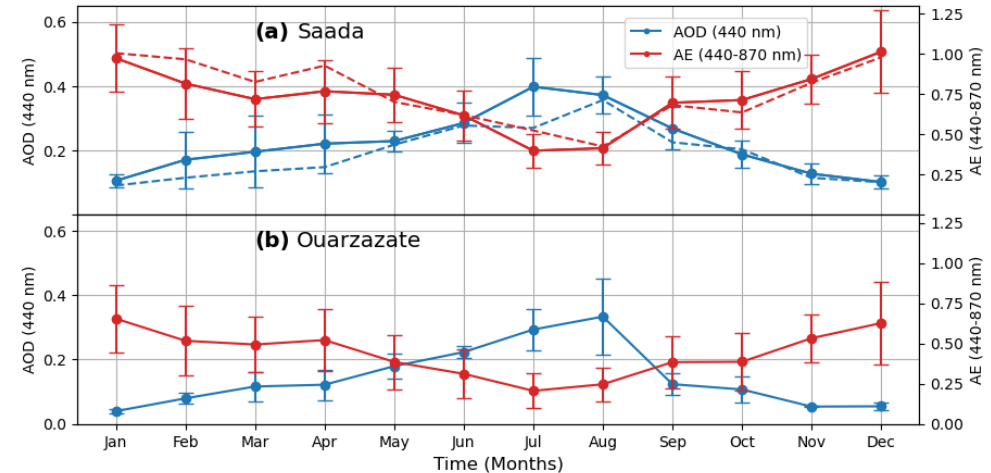
Figure 3. Multi-year mean AOD 440 (in blue) and AE 440 − 870 (in red) for Saada and Ouarzazate. The vertical bars represent the 1 σ standard deviation. The dashed lines represent Saada’s multi-year mean AOD 440 (in blue) and AE 440 − 870 (in red) from 10 February 2012 to 28 June 2015. As for the AE 440 − 870 , the obtained multi-year values for the complete time series show the same seasonal variation for both sites and are anti-correlated with the AOD variations (with r = − 0.968 for Saada and r = − 0.914 for Ouarzazate), with a minimum in summer (0.40 ± 0.11 and 0.21 ± 0.11 for Saada and Ouarzazate, respectively) and a maximum in winter (1.01 ± 0.26 and 0.65 ± 0.21 for Saada and Ouarzazate, respectively). AEs